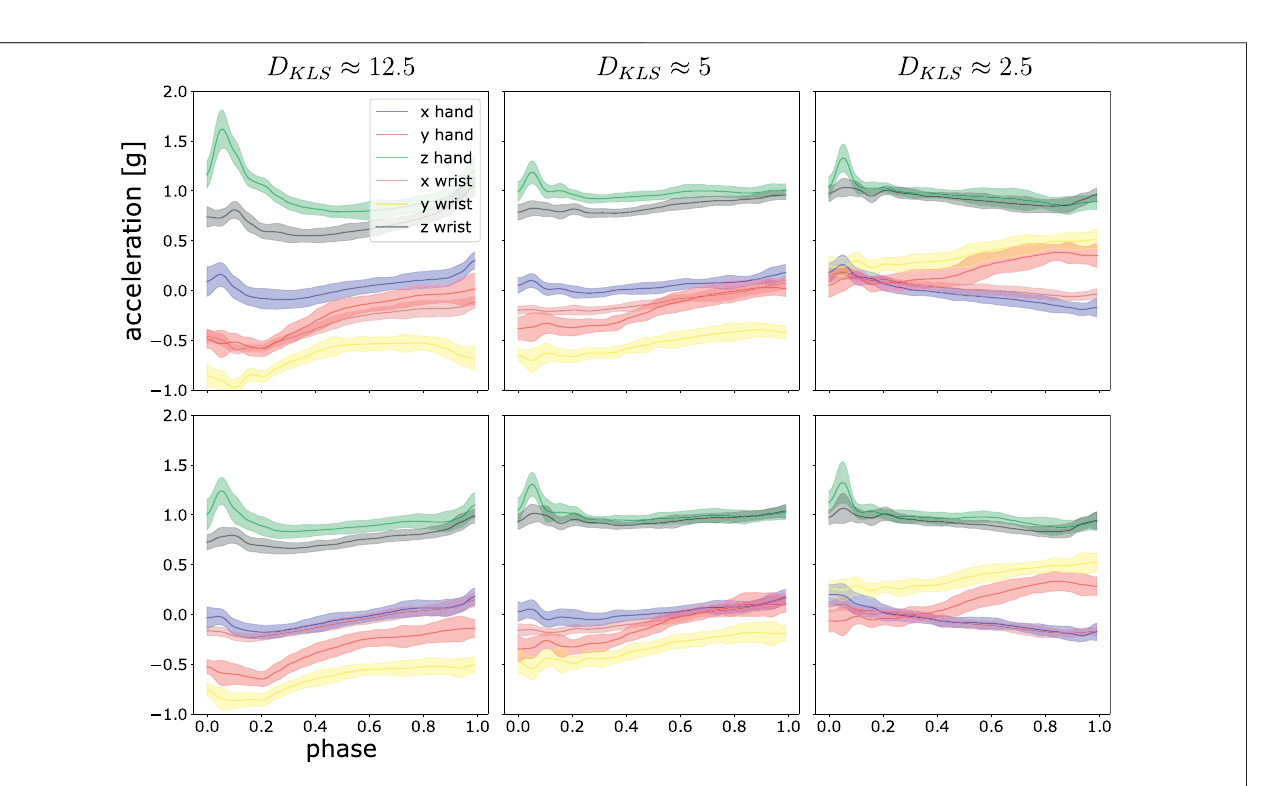
Frontiers in Robotics and AI |